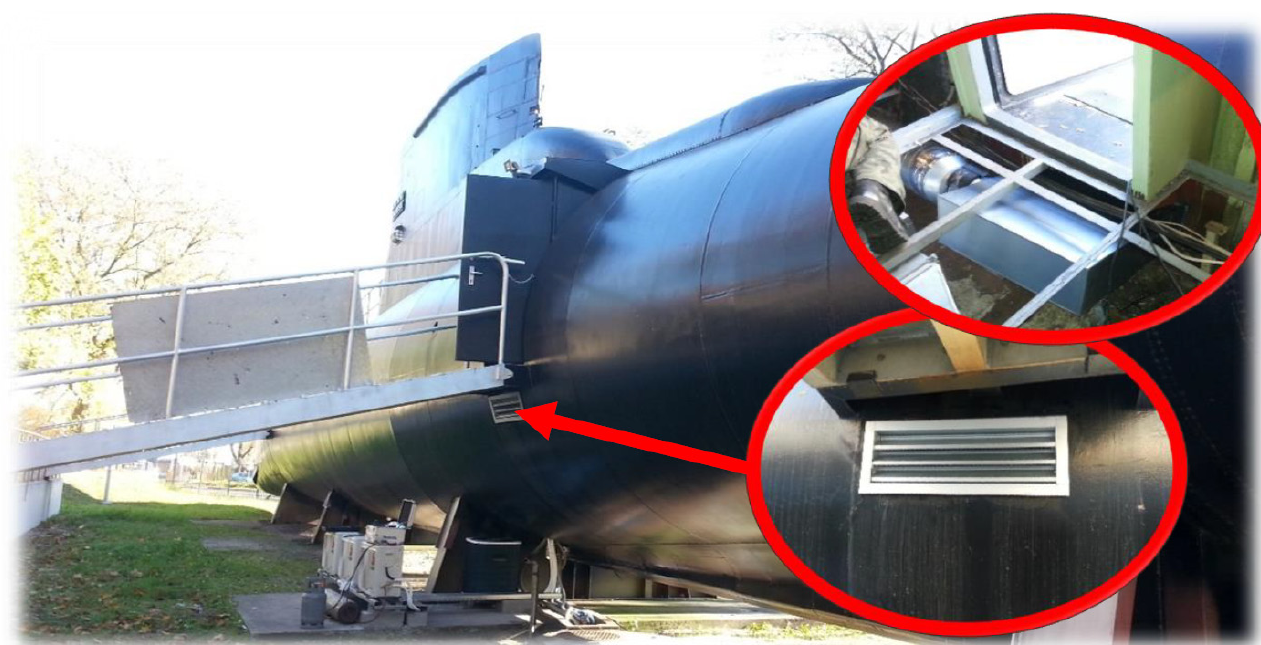
Figure 2. ORP “Jastrz ą b” (S-318 Kobben). Places from which material was taken for test samples.